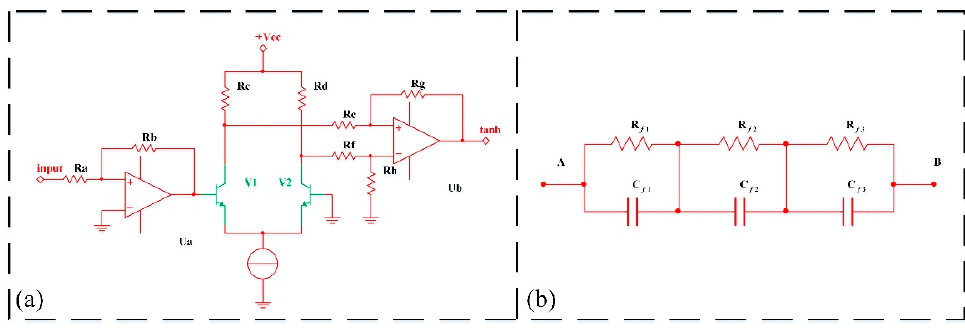
Figure 14. Design of the tanh and order circuits. ( a ) Tanh module unit circuit. ( b ) Fractional order module unit circuit.